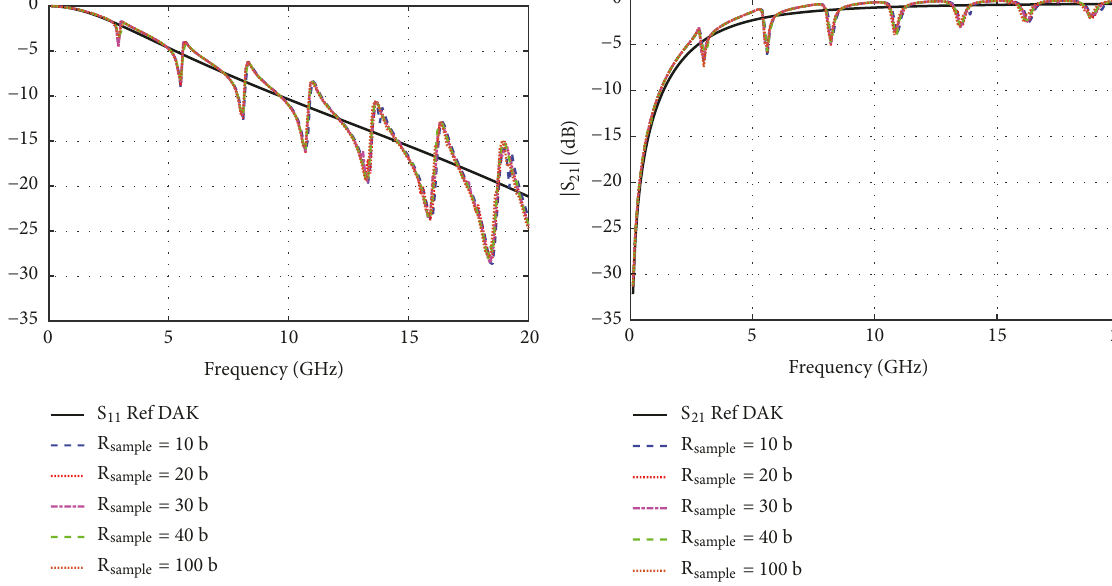
modes at the input/output coaxial lines, for different values of the n